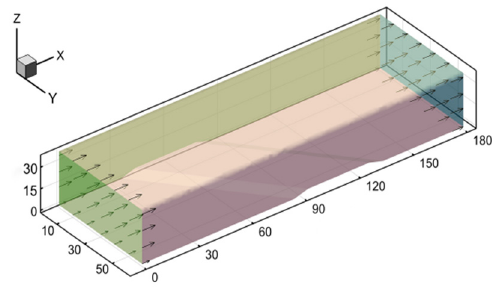
Table 1. 3D model boundary